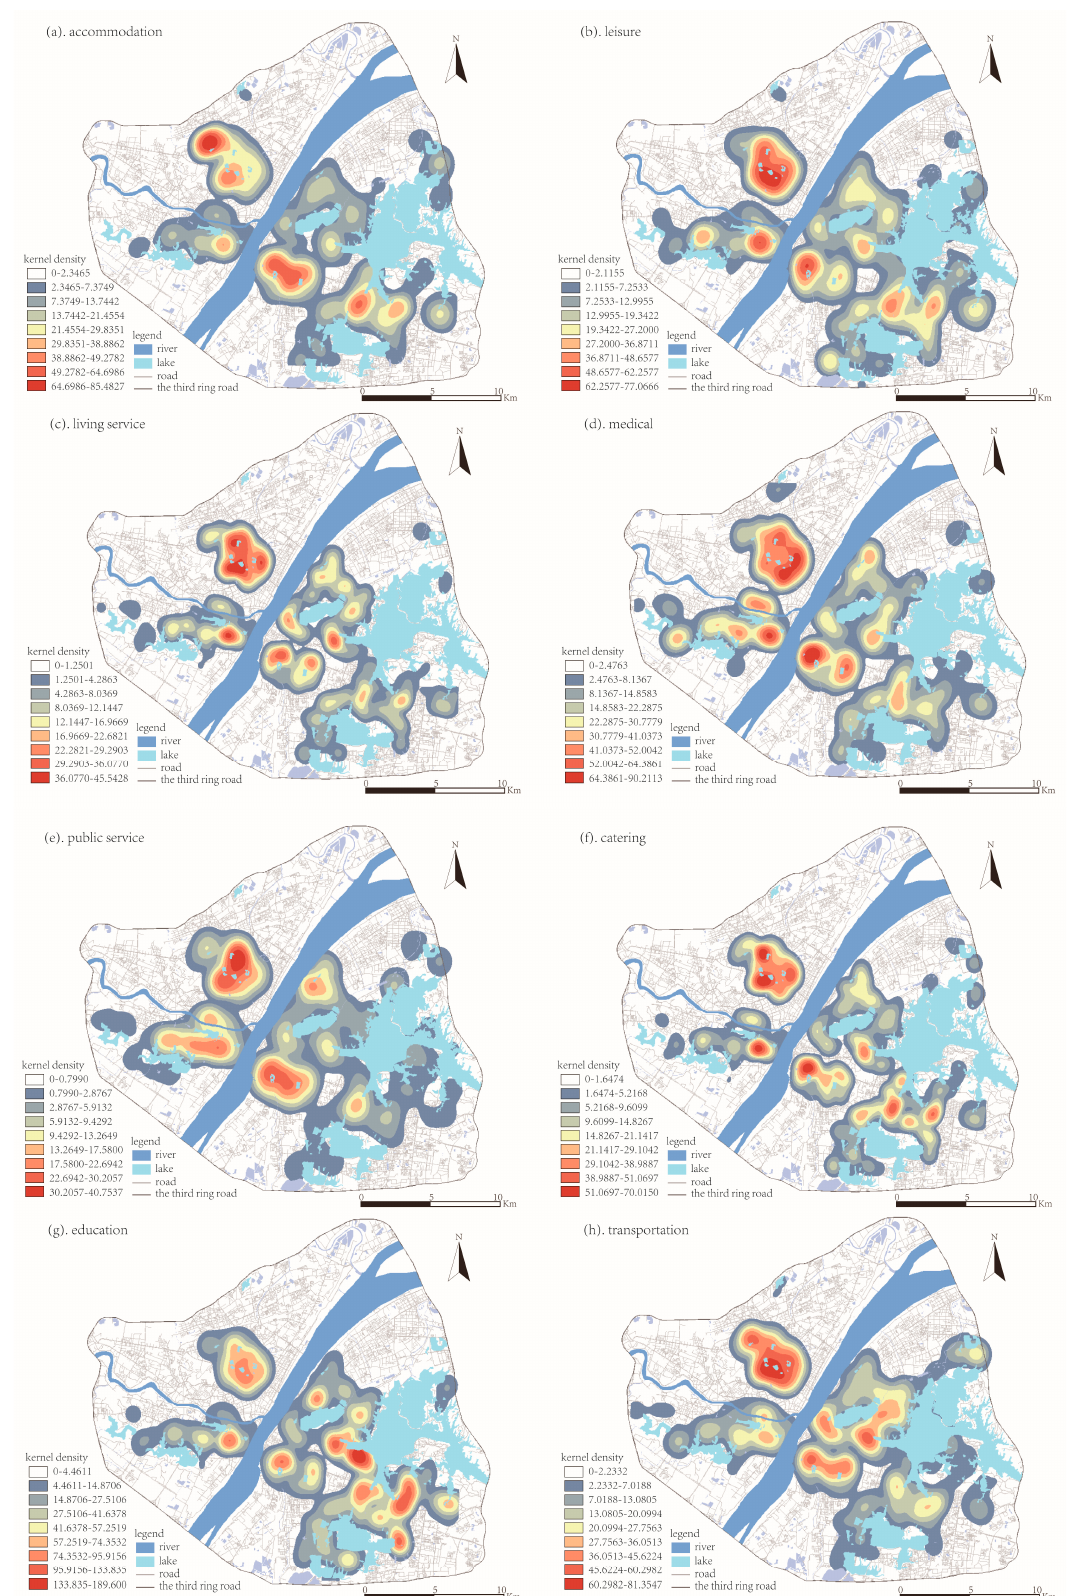
Figure 9. Density analysis of various points of interest (POI) cores in the buffer.